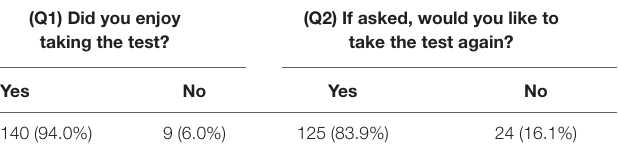
TABLE 1 | Players’ acceptability values for the TacticUP video test for